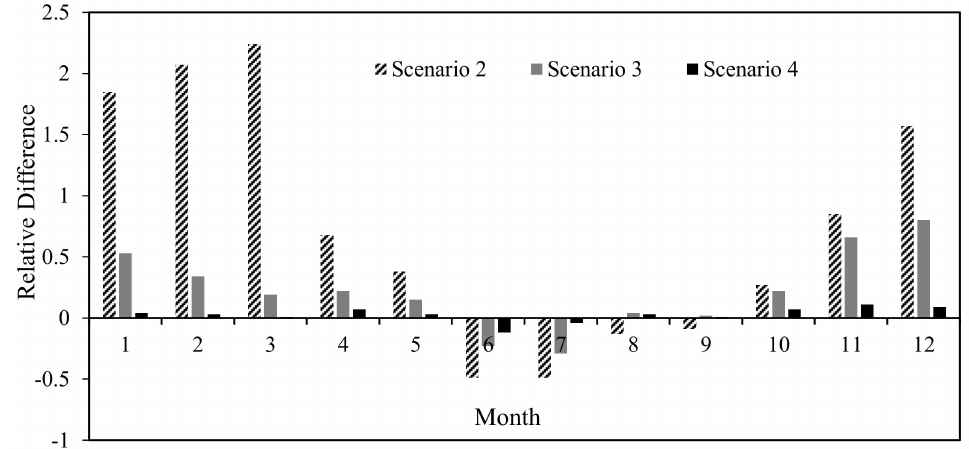
Figure 4. The impact of the reservoir capacity on the monthly average flow (over multiple years) (Scenarios